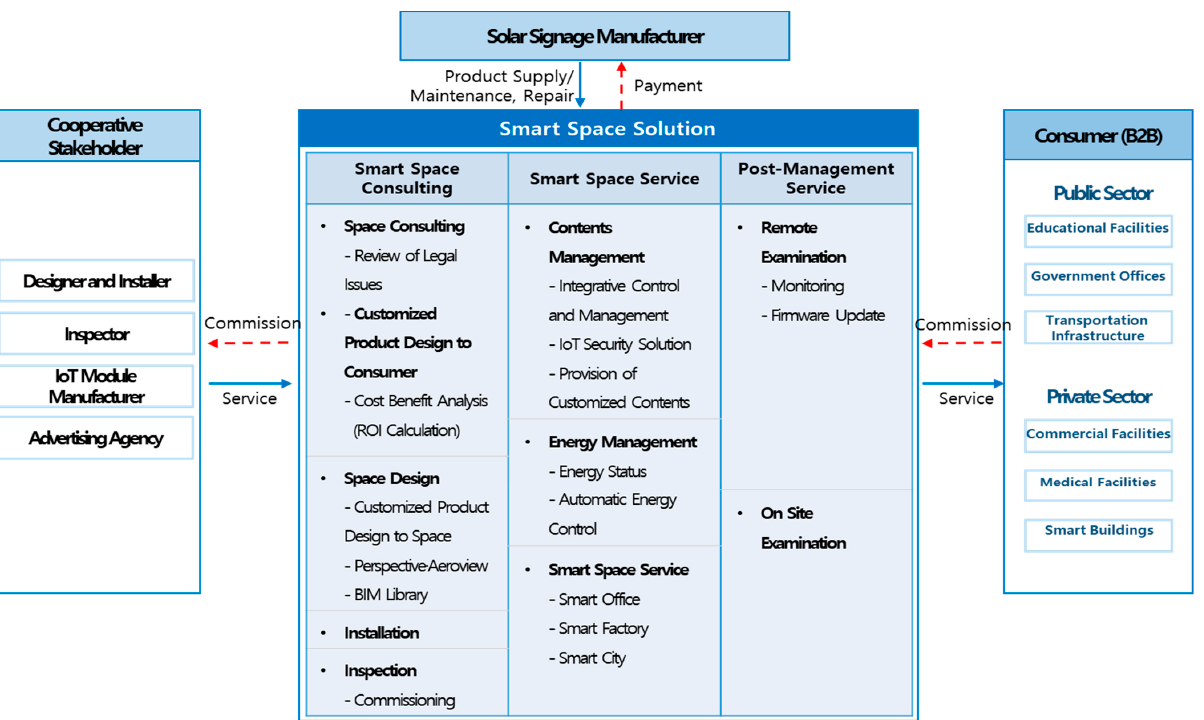
Figure 4. Service prototype.